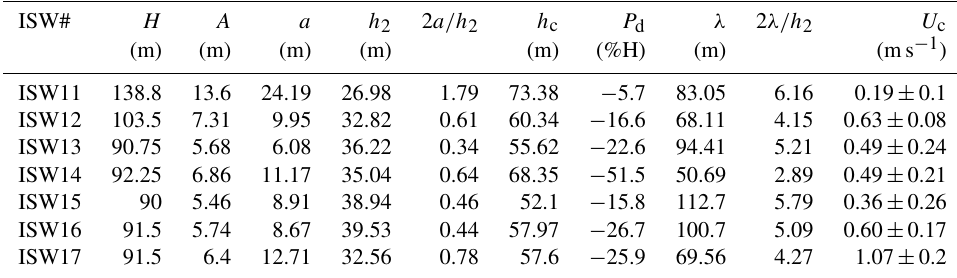
Figure 4. Panels (a) and (b) are the seismic stacked sections S2 and S3, respectively, with observed mode-2 ISWs on the survey line L74. The arrows and the numbers indicate the seven identified mode-2 ISWs ISW11–ISW17. The locations of the seismic stack section S2 and S3 are shown in Fig. 1. The horizontal axis indicates the distance to the starting point of survey line L74. The survey line 74 acquisition time was from 06:31:03GMT on 3 December 2004 to 02:30:01GMT on 4 December 2004. Table 2. Characteristic parameters of the seven mode-2 internal solitary waves in survey line